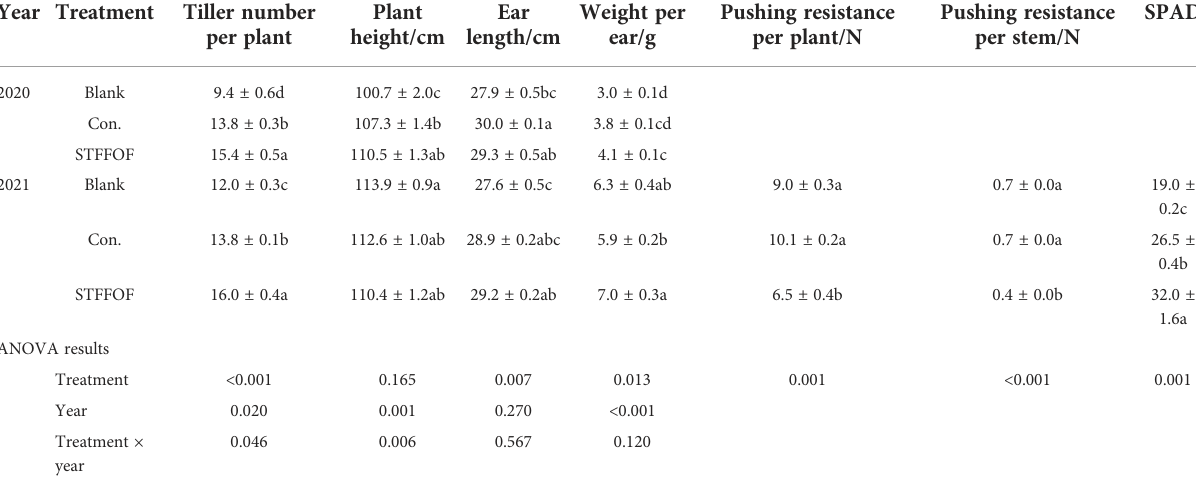
TABLE 2 Effects of soil-testing formula fertilization using organic fertilizer for 11 years on the parameters regarding rice plant in the fi eld. Year Treatment Tiller number per